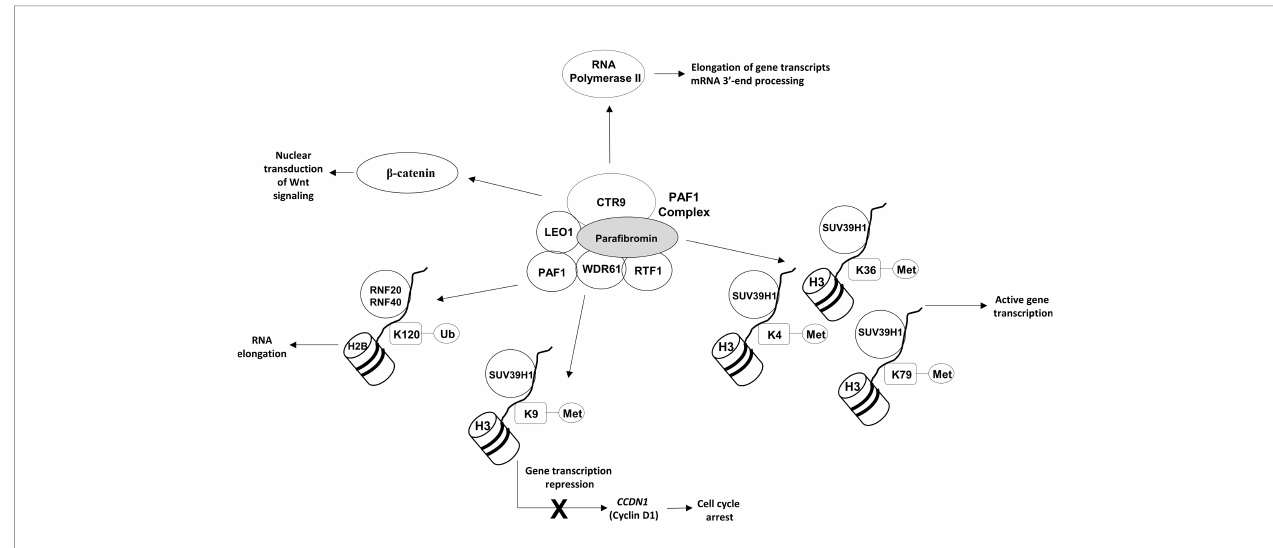
FIGURE 1 | Main roles of para fi